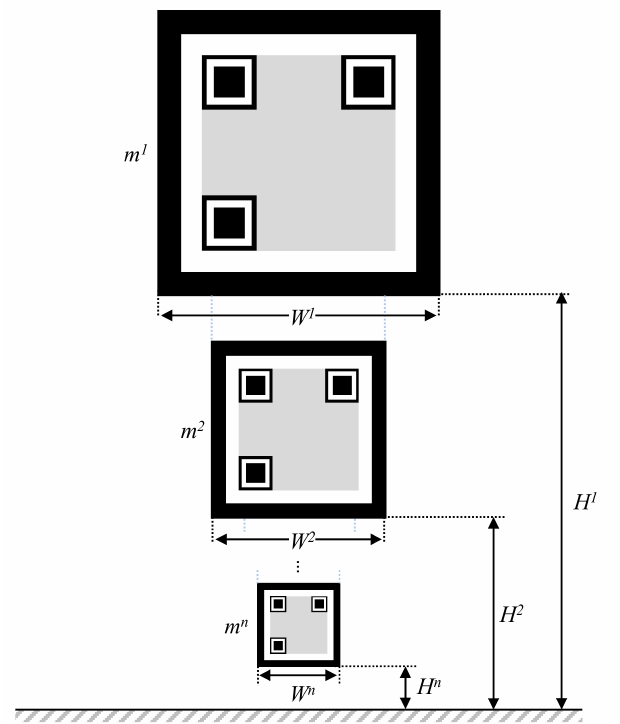
Figure 7. Structure of the proposed hierarchical marker.